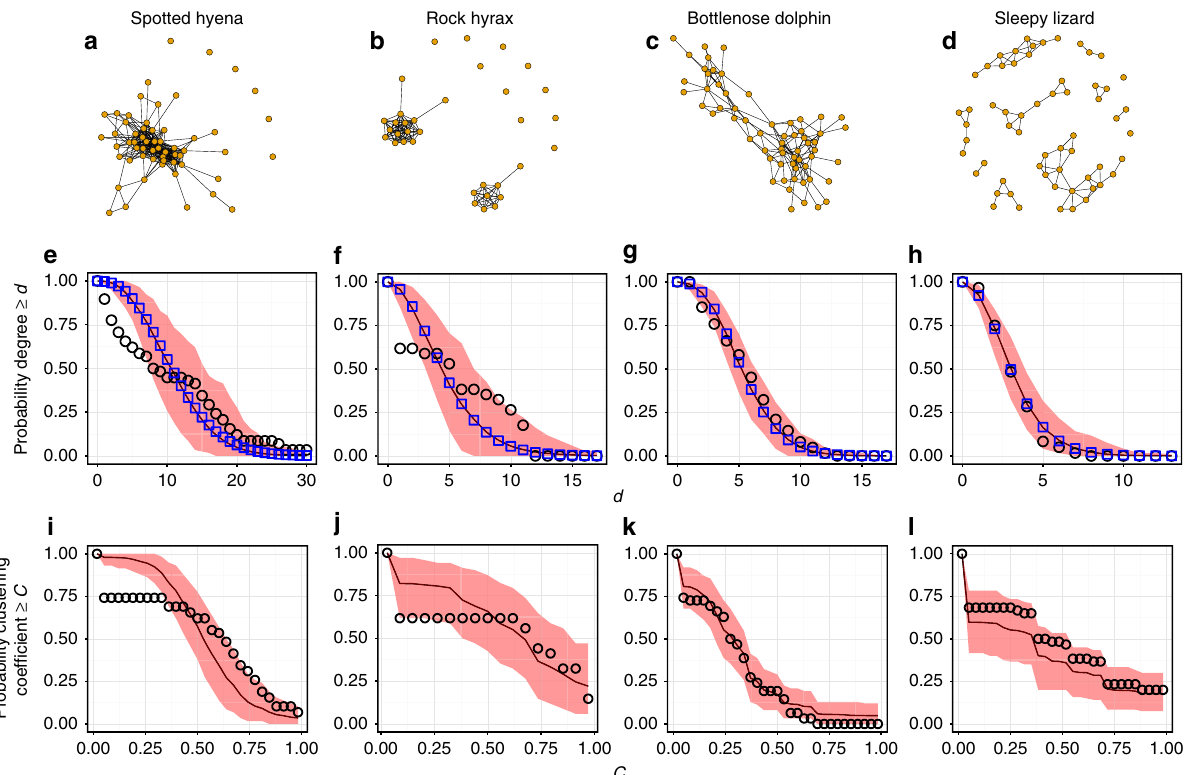
Figure 3 | Social inheritance captures essential properties of animal social networks in the wild. This figure shows that our model can account for the degree and clustering coefficient distributions of observed networks in four species. ( a – d ): observed networks. ( e – h ): cumulative degree distributions of observed and simulated networks ( d stands for degree). ( i – l ): Cumulative local clustering coefficient distributions of observed and simulated networks ( C stands for clustering coefficient). Black circles represent observed values. Blue squares in the middle row depict mean-field estimation for the degree distribution. The red curve denotes mean distribution for 500 simulated networks (2,000 simulation steps) with the species-specific p n and p r values estimated using partial least squares regression (values given in Table 1; see Methods for more on the estimation procedure), whereas light red area depicts 95% confidence intervals.